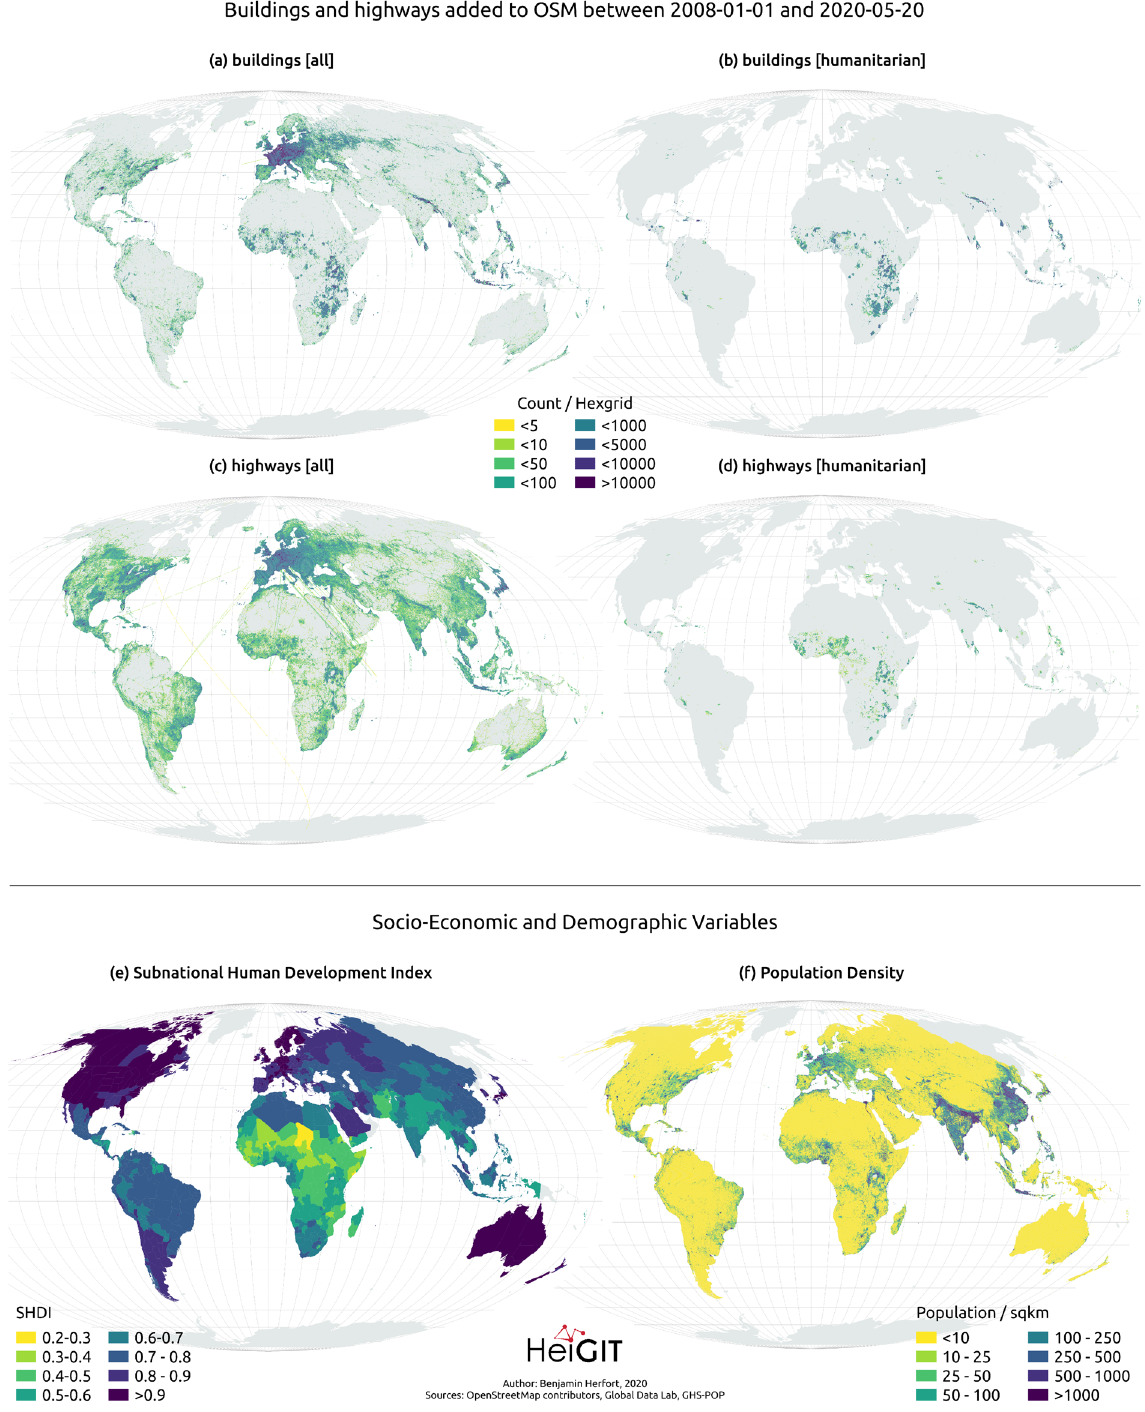
Figure 2. Spatial distribution of the number of ( a )–( b ) buildings and ( c )–( d ) highways added to OSM between 2008/01/01 and 2020/05/20 in regard to overall and humanitarian mapping activities. Further the maps depict the spatial distribution of ( e ) SHDI and ( f ) population density. Note that population count (and not density) is used in the statistical models. Created using QGIS 3.10.8 (https